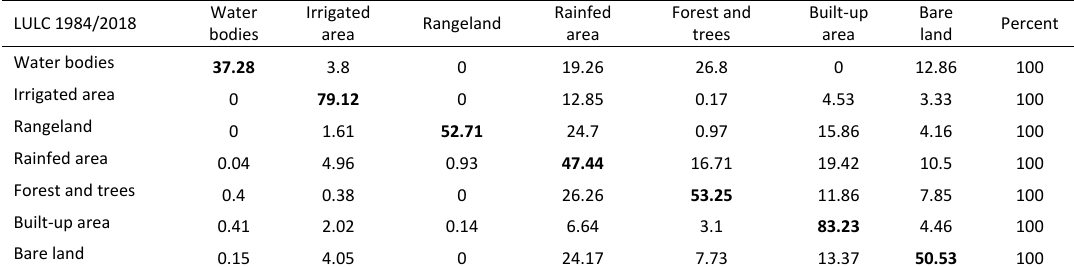
Table 6g: Probability of transition class for LULC 1984-2018 (total round)